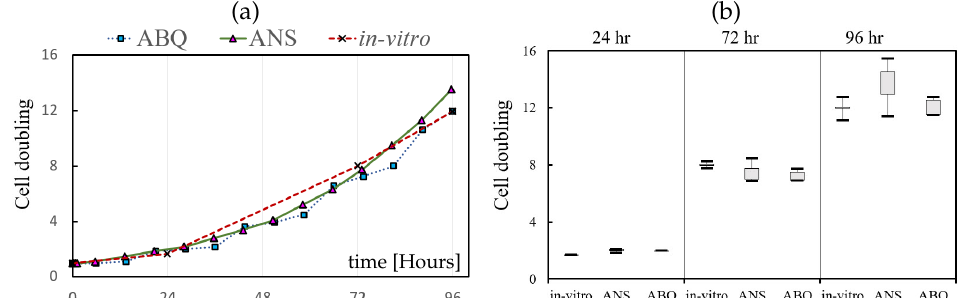
Figure 4. Cell doubling. ( a ) Comparison of the mean values after 96 h in a cells-in-culture simulation using the ANS and ABQ models, with results of the in vitro model (Section 2.2). ( b ) Dispersion of the results due to the random nature of the